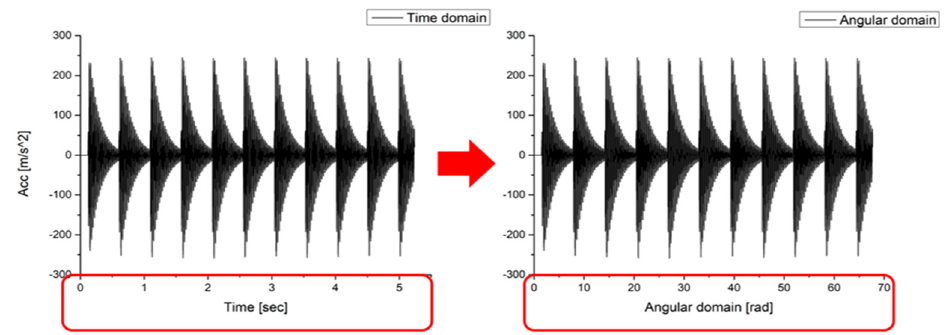
Figure 12. Conversion of the flat signal from the time domain to an angular domain.